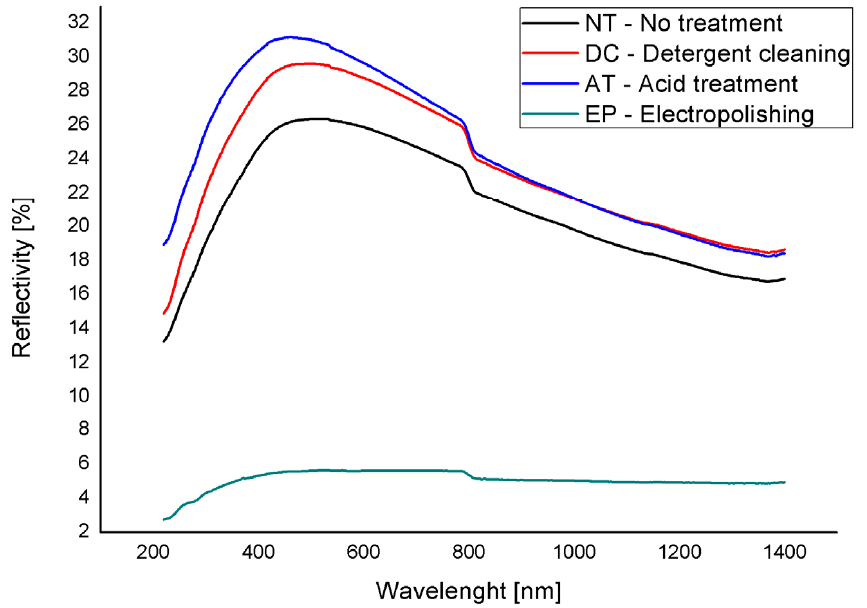
Figure 2. Spectral reflectivity of substrates according to treatment types (NT-No treatment, DC-Detergent cleaning, AT-Acid treatment, EP-Electropolishing).